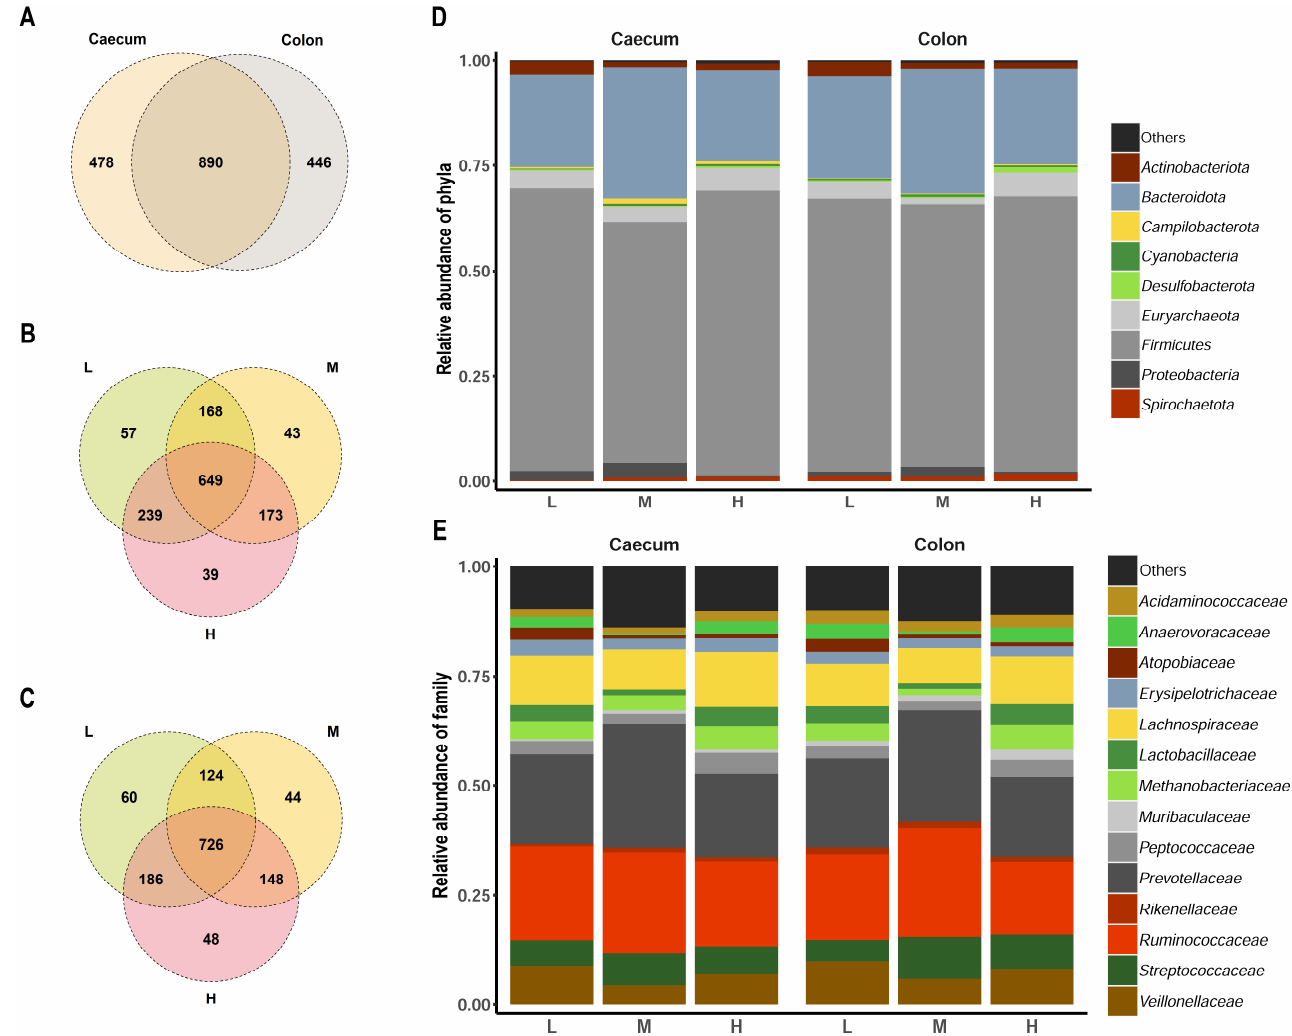
Figure 2. Microbial composition of caecum and colon digesta of pigs fed with varying mineral P levels. Venn diagram representation of specific and overlapping OTUs considering ( A ) caecum and colon digesta samples, ( B ) caecum digesta samples from the three dietary groups, and ( C ) colon digesta samples from the dietary groups. Taxa plots at ( D ) phylum and ( E ) family level with the 9 and 14 top taxa, respectively. L, M, H—dietary groups receiving lower, medium, and higher mineral P levels.